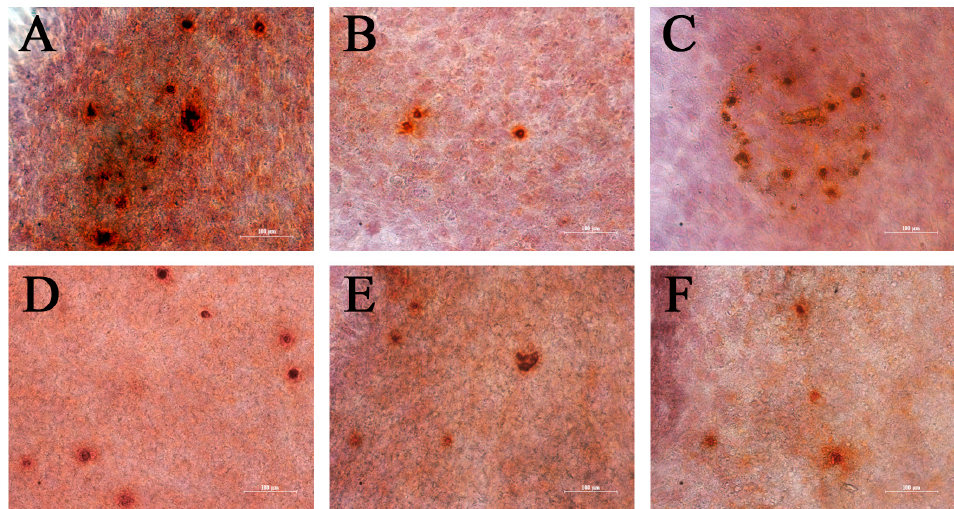
Figure 15. Alizarin Red S staining images in MC3T3-E1 cells cultured for 3 weeks on different substrates: ( A ) glass, ( B ) PLGA, ( C ) GdPO 4 · H 2 O/PLGA, ( D ) GdPO 4 · H 2 O@SiO 2 /PLGA, ( E ) GdPO 4 · H 2 O@SiO 2 –APS/PLGA and ( F ) PBLG-g-GdPO 4 · H 2 O/PLGA. Bar = 100 µ m.